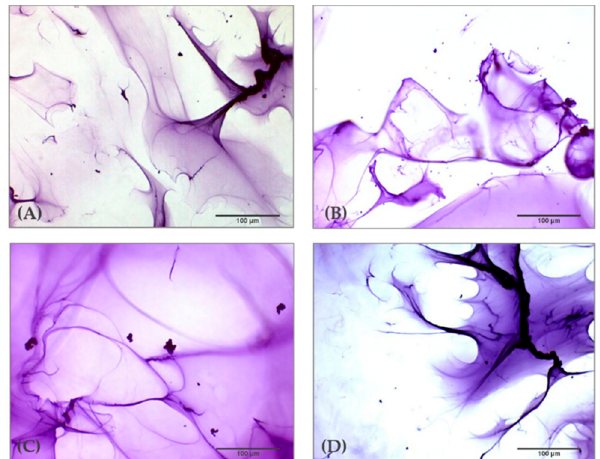
Figure 2. Optical microscopic examination (10X) of four HA dermal fillers cross-linked with BDDE after staining with toluidine blue 1%. ( A ) HA 22 mg/mL cross-linked with BDDE; ( B ) HA 24 mg/mL cross-linked with BDDE; ( C ) HA 26 mg/mL cross-linked with BDDE; ( D ) HA 28 mg/mL cross-linked with BDDE.